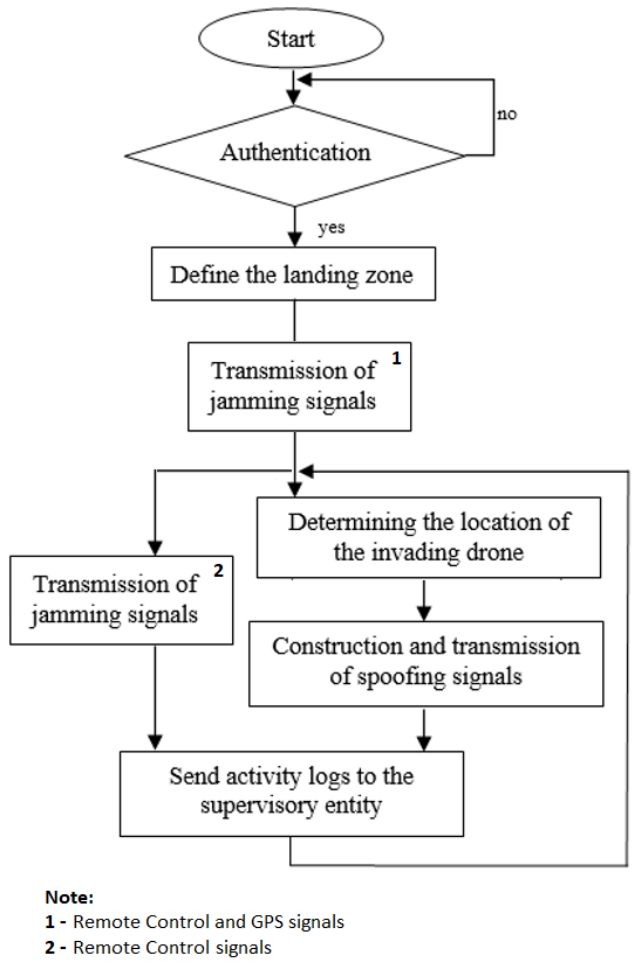
Figure 2. System Figure 2. System flowchart.